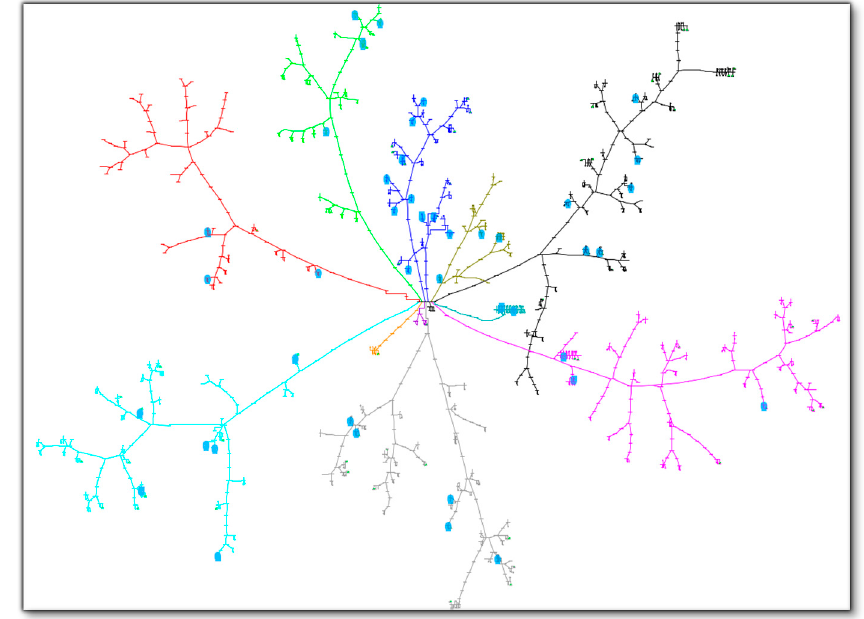
Figure A8. Use case 5—Location of PVs.